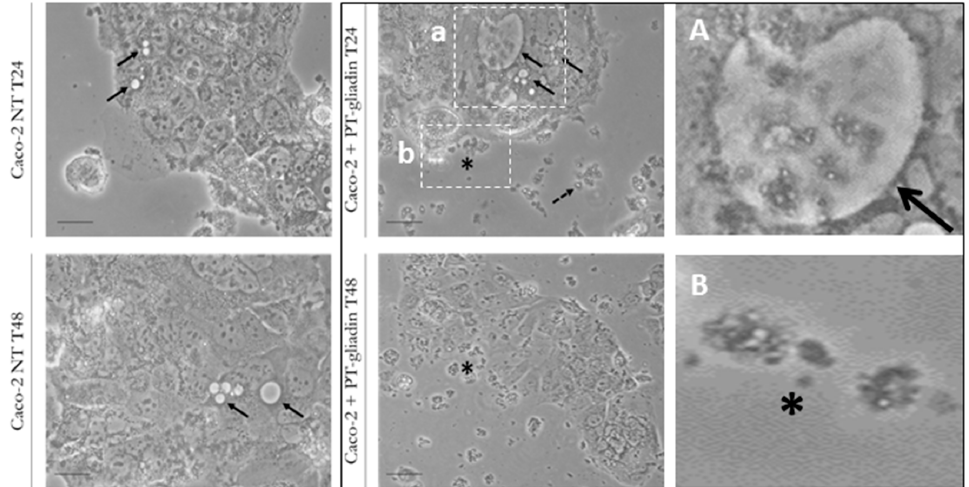
Figure 3. Morphological evaluation of PT-gliadin administration in Caco-2 cells by optical microscopy analysis. Caco-2 cells were incubated with PT-gliadin ( right , 1 µg/µL) or not- (NT) ( left ) and visualized using inverted optical microscope Eclipse Nikon TS100 at 24–48 h p.t. Continuous arrows indicate intra-cellular vesicles, dashed arrows point for extra-cellular PT-gliadin aggregates in proximity to the plasma membranes (asterisks) (scale bars = 10 µm). ( A , B ) are magnifications of a and b panels, respectively.